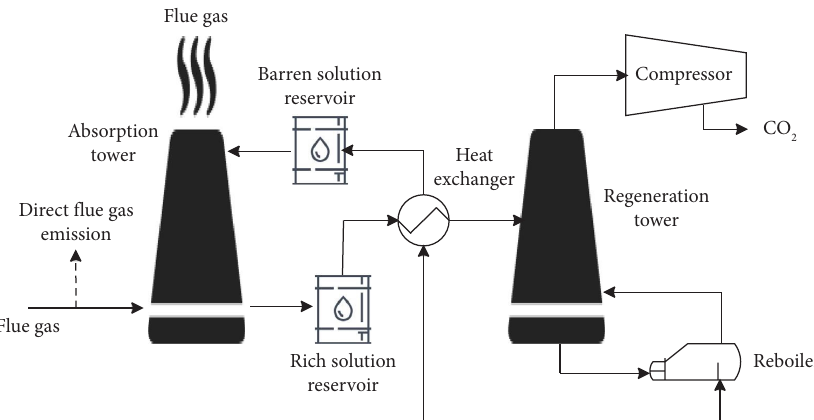
Figure 2: Structure of liquid storage carbon capture system.